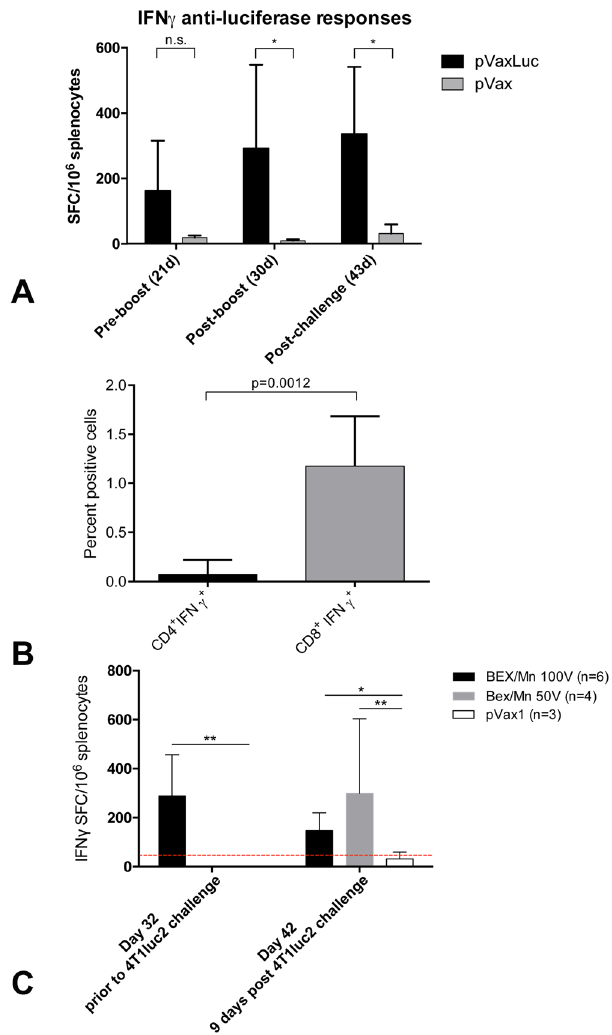
Figure 9. Cellular immune response to peptide GFQSMYTFV representing an immunodominant CTL epitope of luciferase (LucP; ref. 21) in mice immunized with Luc DNA (pVaxLuc). The average number of IFN- γ producing splenocytes per mln cells in mice receiving pVaxLuc followed by electroporation using Dermavax (n = 6), or BEX devices at 100 V (n = 6), or empty vector pVax1 with electroporation using BEX device at 100 V (n = 6) after priming (day 21), boosting (day 30), and after challenge with 4T1luc2 cells (day 9, or 43 from the start) (see Methods for details) ( A ); FACS of the pooled splenocytes of Luc-gene immunized mice detecting LucP-specific secretion of IFN- γ by CD8 + T cells ( B ); Average LucP-specific IFN- γ response of mice immunized with Luc DNA and electroporated using CUY21EditII (BEX) at 50 V and 100 V ( C ). Red line indicates the cut-off for specific IFN- γ response as number of spots registered in non-immune (control and vector immunized) mice + 3 STDV. * p < 0,05, Luc DNA immunized mice electroporated at 100 V, and ** p < 0,1, Luc DNA immunized mice electroporated at 50 V compared to vector immunized mice (Mann- Whitney test; STATISTICA AXA